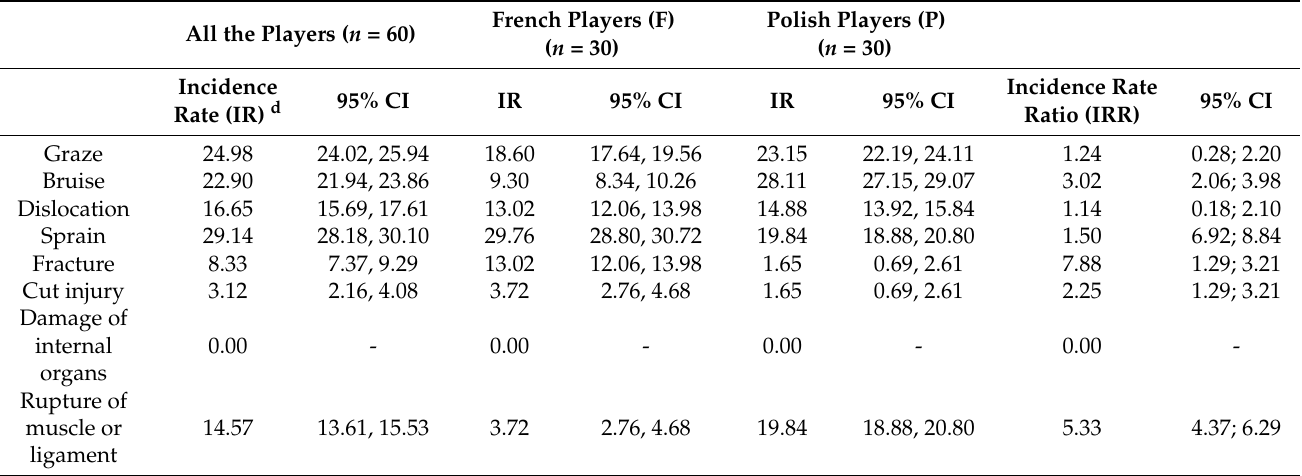
Table 3. Incidence rates of injuries obtained among the rugby players ( n = 60) by country.